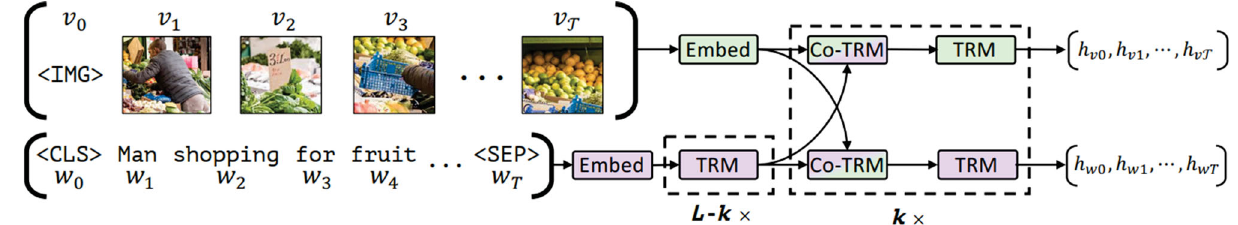
Fig. 23 Overview of ViLBERT. Reproduced with permission from Ref. [40], c (cid:2) The Author(s)